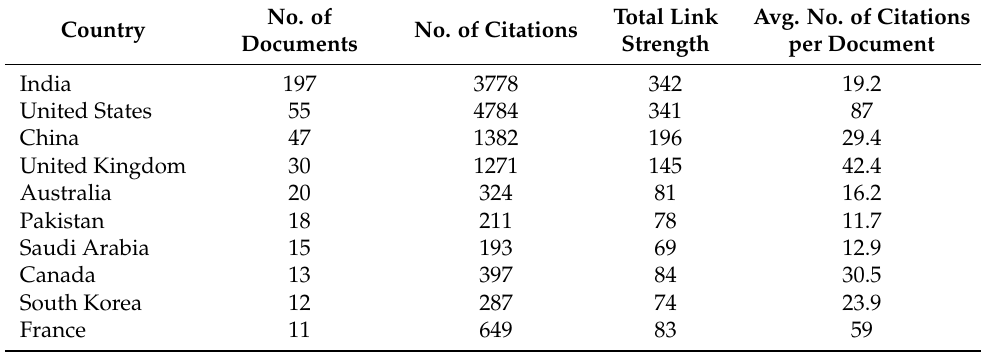
Table 2. List of top countries with the no. of documents and citations.